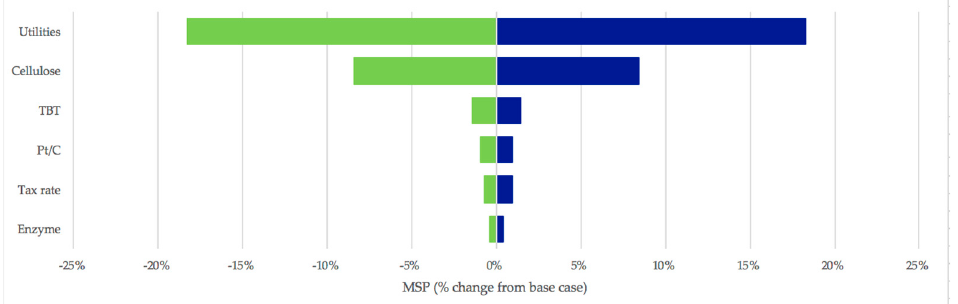
Figure 5. Sensitivity analysis of Scenario 1. TBT = tetrabutyl titanate, the catalyst used in PEF and PTT synthesis; Pt/C = the catalyst used in cellulose − to − HMF conversion.